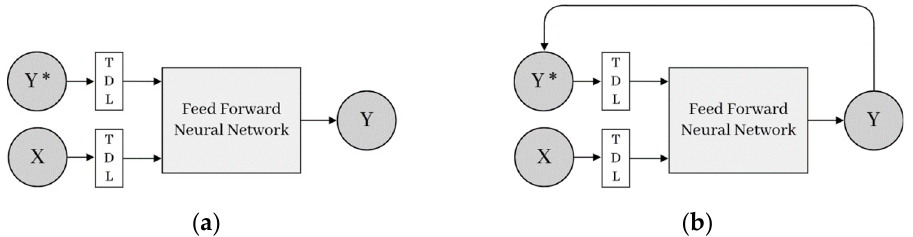
Figure 6. ( a ) Open (series-parallel) mode of NARX; ( b ) Closed (parallel) mode of NARX.